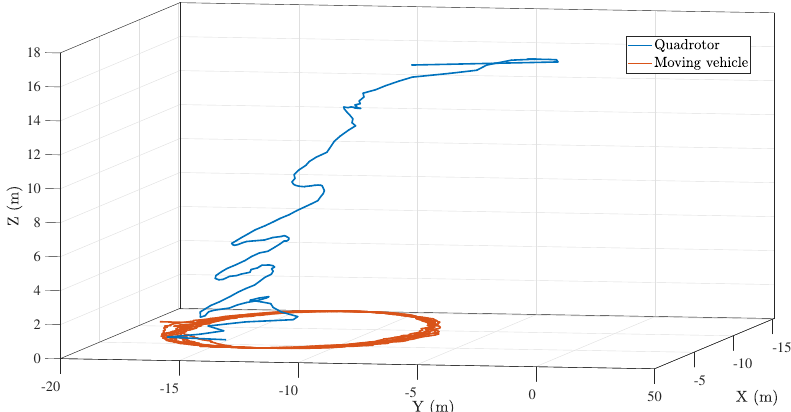
Figure 8. Landing trajectory followed by UAV when ground vehicle moves along a circular path (5 m